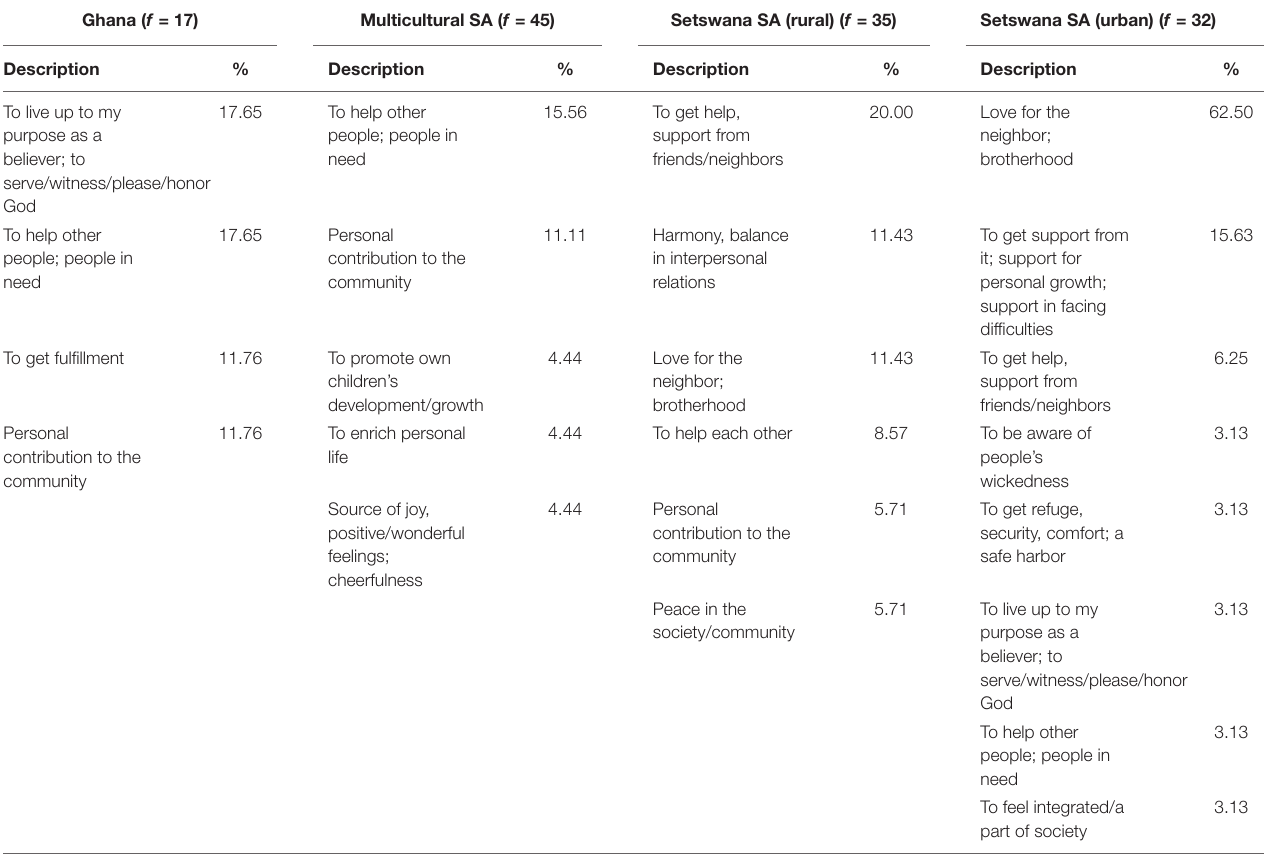
TABLE 10 | Percentages of the most frequent codes in the motivations for meaning sources in the community/society domain of life. Ghana ( f = 17) Setswana SA (rural) ( f = 35) Setswana SA (urban) ( f =